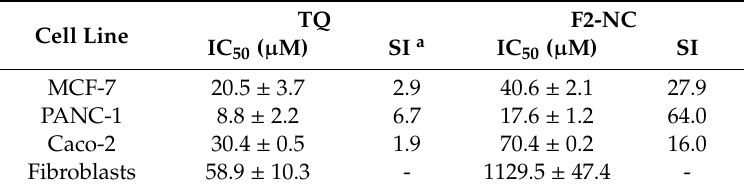
a Calculated by dividing the IC 50 value obtained in human dermal fibroblasts by the IC 50 value obtained in each cancer cell